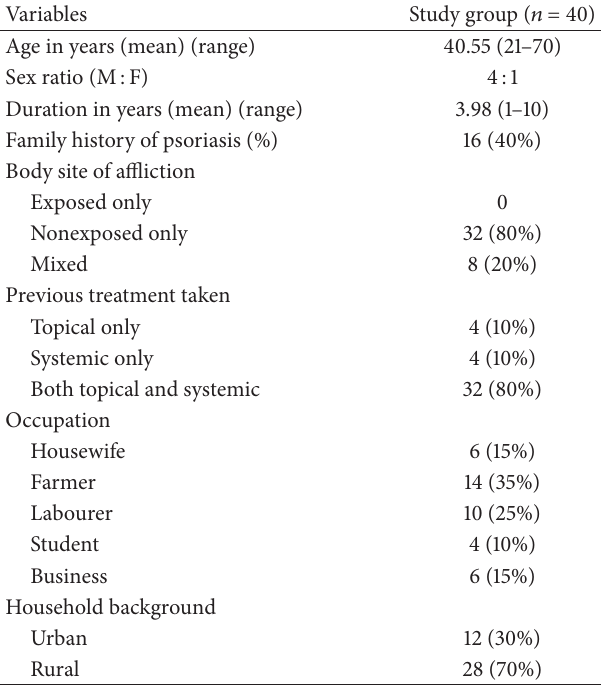
Table 1: Demographic and baseline clinical